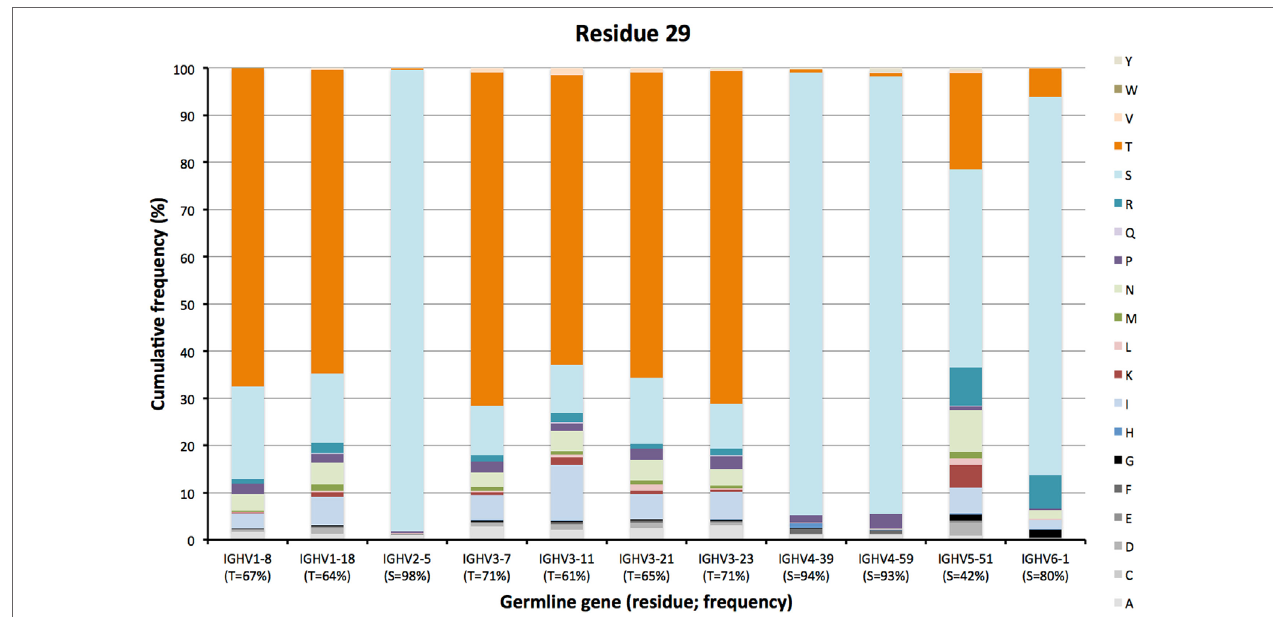
FigUre 3 | Diversity of residues encoded by transcripts of different germline gene origins in position 29 of VH of IgG. The germline-encoded residues and their frequencies in IgG-encoding transcripts are shown at the bottom of the graph. Note the extensive diversification of S29 in IgG-encoding transcripts derived from IGHV5-51 but not from other genes, in particular IGHV2-5, IGHV4-39, and